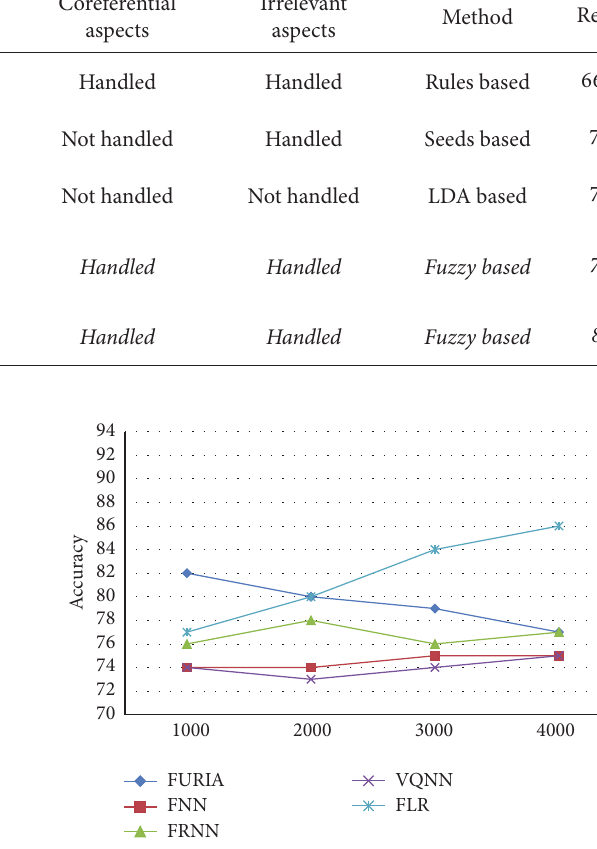
Figure 9: Classifiers performance with different instances sizes on hotels